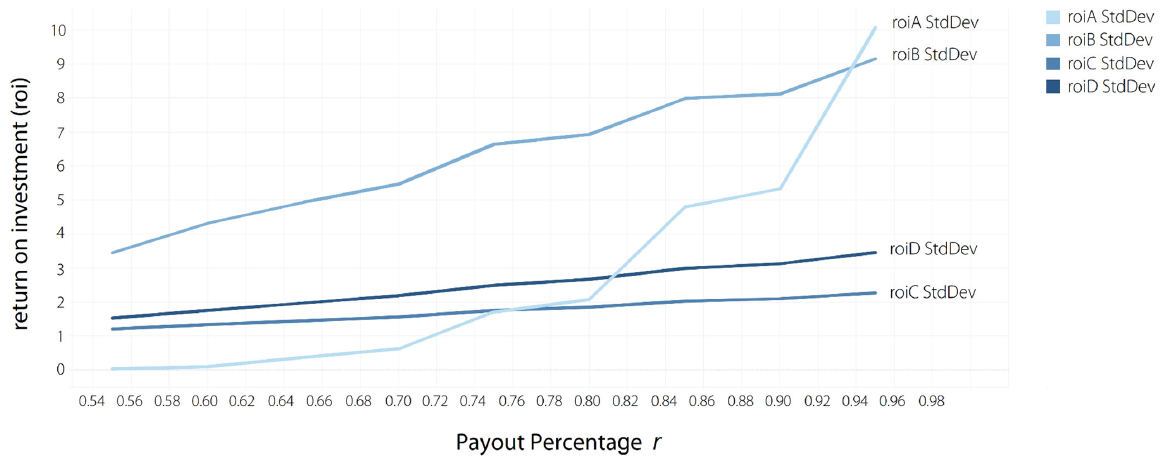
Figure 8. Change in (median) 𝑟𝑜𝑖 𝑆𝑡𝑑𝐷𝑒𝑣 of the strategies in relation to payout percentage 𝑟 on the x ‐ axis.